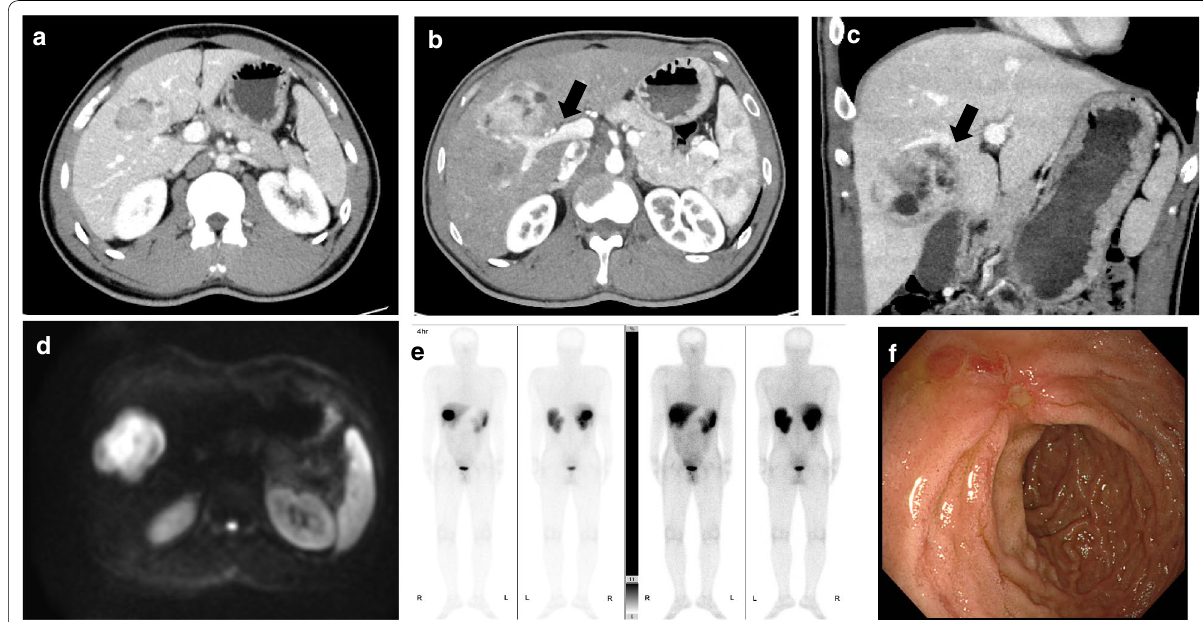
Fig. 1 Preoperative imaging. a Abdominal contrast-enhanced computed tomography (CT) showed a tumor at the first visit (55 mm). b Abdominal contrast-enhanced CT showed a hypervascular tumor with cystic degeneration in segment 5/6 of the right hepatic lobe (78 mm). The tumor is in close proximity to the right branch of the portal vein (arrow). c The tumor partly involved the S4a region, and invasion to the middle hepatic vein (MHV) was suspected (arrow). d Magnetic resonance imaging (MRI) showed a hyperintensity on diffusion-weighted imaging. e Somatostatin receptor scintigraphy (SRS) showed abnormal uptakes in the liver. f Upper gastrointestinal endoscopy showed multiple duodenal ulcers (H1